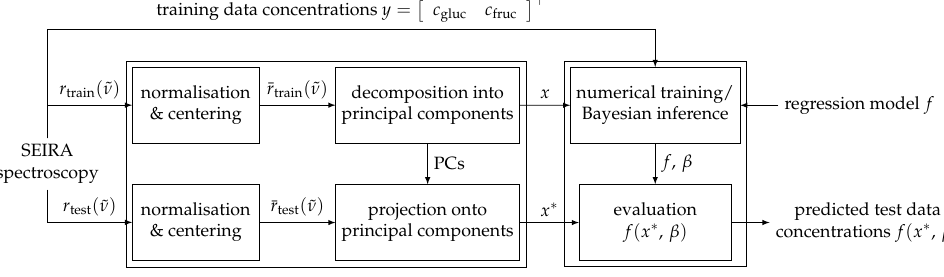
Figure 7. Graphical abstract of the signal processing routine performed in this paper: The mea- sured data are split into training and test samples, normalised with respect to the L 2 -norm and centered. Subsequently, the data are decomposed into or projected onto its principal components and passed on to the various regression models which finally output the predicted glucose and fructose concentrations in the